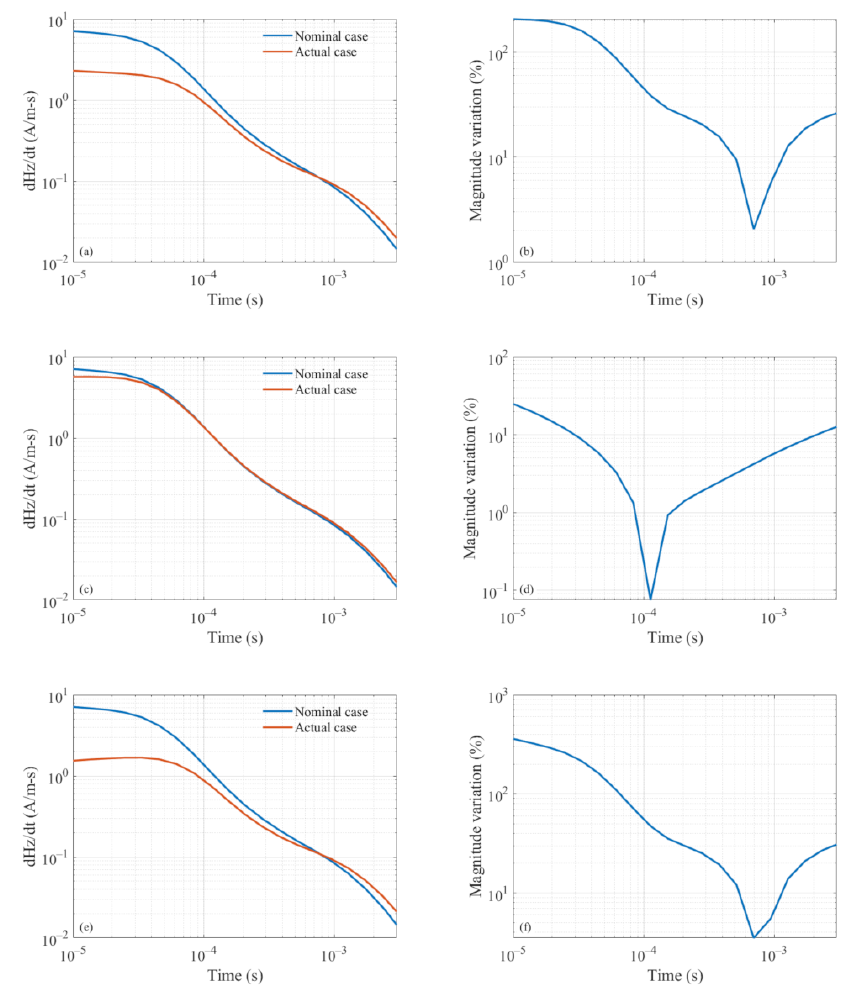
Figure 5. dHz/dt responses of the nominal situation and the actual geometry over a three-layered earth model. ( a ) crooked transmitter only, ( c ) tilted receiver only, and ( e ) both crooked transmitter and tilted receiver. ( b , d , f ) show the mismatch in the magnitude for ( a , c , e ), respectively. 4.